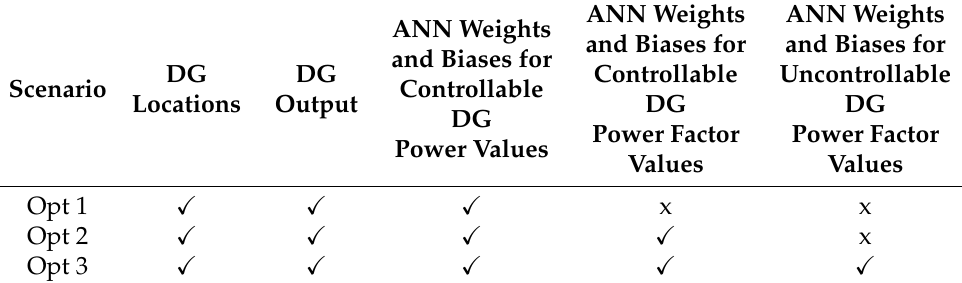
Table 2. The optimization decision variables for different